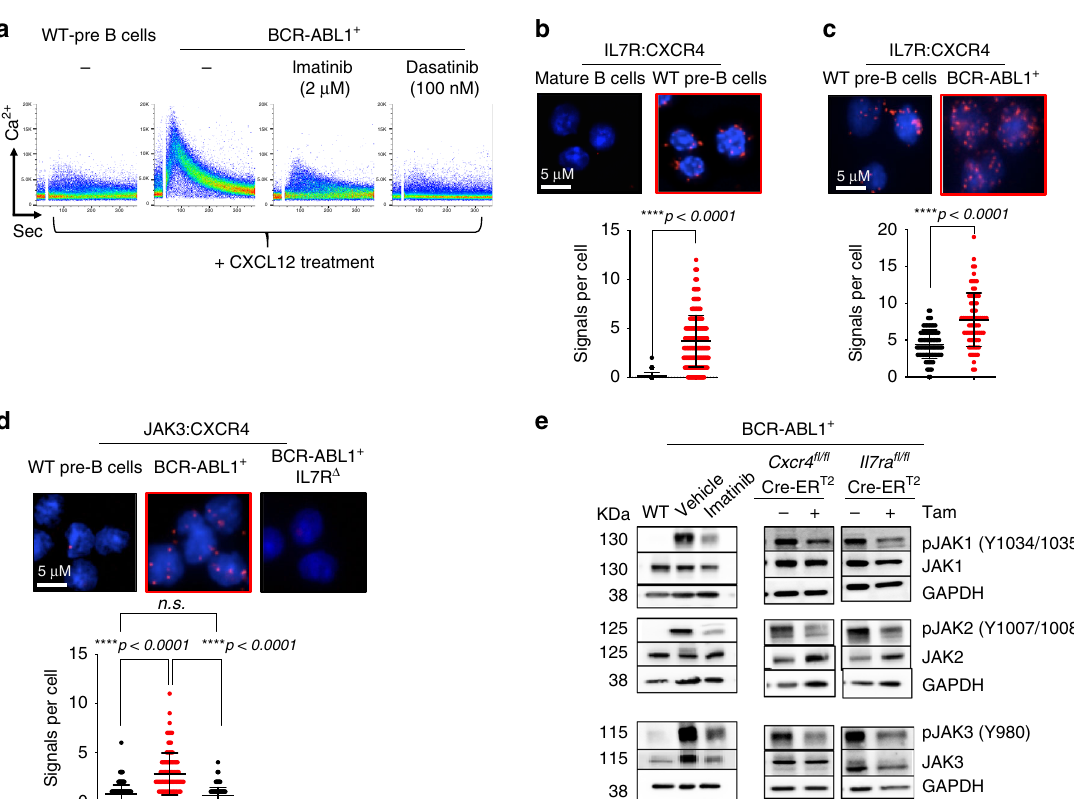
Fig. 4 Synergism between CXCR4 and IL7R in BCR-ABL1-induced cell. a BCR-ABL1 acts downstream of CXCR4. Shown are fl ow cytometry plots for Ca 2 + mobilization in response to CXCL12 treatment (100 ng/ml) in WT as compared with BCR-ABL1-transformed cells with or without kinase inhibitor treatment as indicated. The results are representative of three independent experiments. b Proximity ligation analysis (PLA) to detect the close association of IL7R and CXCR4 on the surface of WT BM-derived pre-B cells as compared with mature B cells (which lacks IL7R expression; Supplementary Fig. 8a). c PLAs showing increased association of IL7R and CXCR4 on the surface of BCR-ABL1-transformed cells. d PLA showing recruitment of JAK3 to CXCR4 in BCR-ABL1-transformed cells. This association was lost upon inducible deletion of Il7r using Cre-ER T2 (IL7R Δ ) system. Close proximity is represented by red dots. b – d Quanti fi cation shows number of signals per cell, error bars represent mean ± SD. Unpaired t -test, two-sided. The results shown are representative of three independent experiments. Exact p values ( c ) 0.00000000006167, approximate p value ( b ) <0,000000000000001, approximate p value ( d ) <0,000000000000001. e Left panel, western blot analysis for increased phosphorylation of the JAK kinases by BCR-ABL1 activity. Right panel, western blot showing that inducible deletion of CXCR4 or IL7R results in reduced phosphorylation of all JAK kinases. The results are representative of three independent experiments. KDa kilo